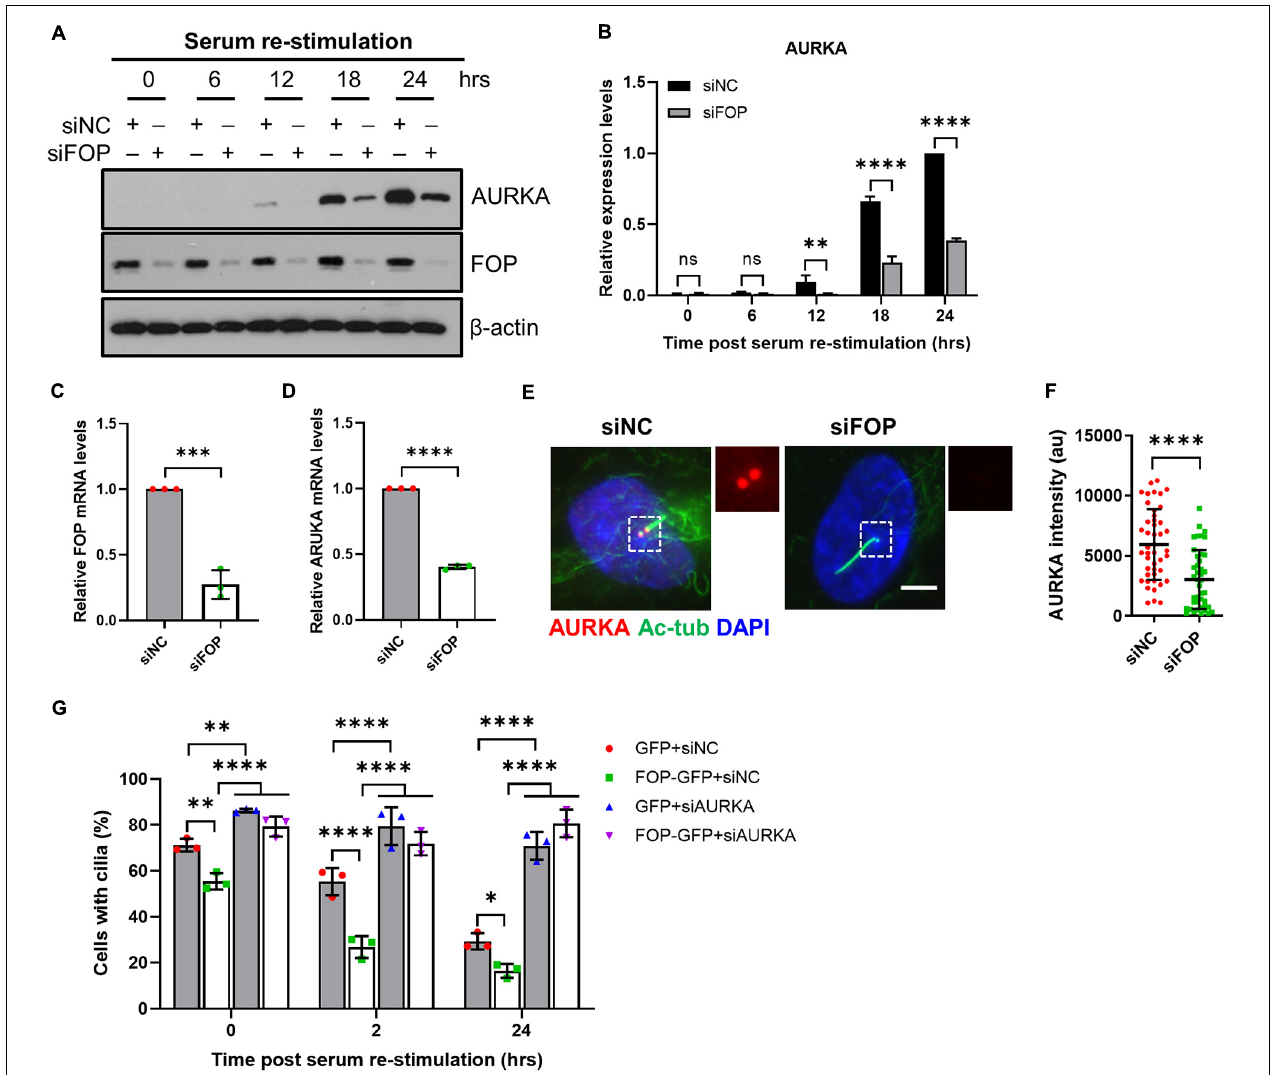
FIGURE 4 | FOP-promoted cilia disassembly during cell cycle re-entry is dependent on AURKA. (A) Immunoblotting analysis of the total levels of AURKA in siNC or siFOP treated cells at 0, 6, 12, 18, and 24 h post serum re-stimulation. (B) Quantification data described in (A) ; ns, not significant; ∗∗ p < 0.01; ∗∗∗∗ p < 0.0001 (Two-way ANOVA followed by Tukey’s multiple comparisons test). (C,D) qRT-PCR analysis of FOP (C) and AURKA (D) mRNA levels in siNC and siFOP-treated cells; ∗∗∗ p < 0.001, ∗∗∗∗ p < 0.001 (unpaired, two-tailed, Student’s t -test). (E) RPE1 cells transfected with siNC or siFOP were immunostained for AURKA (red) and acetylated α -tubulin (Ac-Tub; green). The nuclei were stained with DAPI. Scale bar, 5 µ m. (F) Quantification of AURKA intensity at the ciliary base described in (E) ; n = 45, 44 for siNC or siFOP treated cells, respectively; ∗∗∗∗ p < 0.0001 (unpaired, two-tailed Student t -test). (G) RPE1 cells expressing GFP or FOP-GFP were transfected with siNC or AURKA siRNAs and subjected to cilia disassembly assay. Cells were fixed at the indicated time points and immunostained for Arl13b and γ -tubulin. The percentage of ciliated cells were quantified. At least 100 cells per sample were analyzed in each experiment; ns, not significant; * p < 0.05; ∗∗ p < 0.01; ∗∗∗∗ p < 0.0001 (Two-way ANOVA followed by Tukey’s multiple comparisons test). Data are presented as mean ± SD from three independent